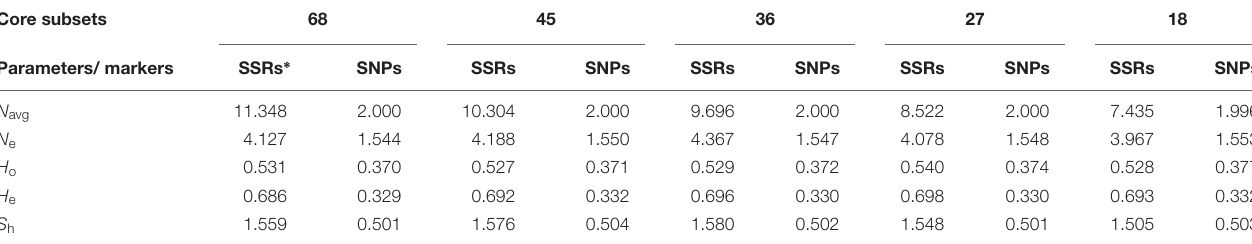
TABLE 2 | Comparisons of genetic diversity parameters found by means of SSRs and EST-SNPs in the different WOGB core collections. Core subsets 68